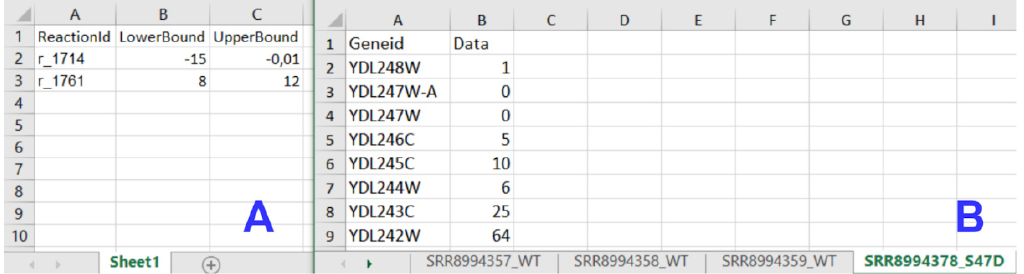
Figure 4. Input data file structure; ( A ) Medium data file structure; ( B )Transcriptomics data file structure.